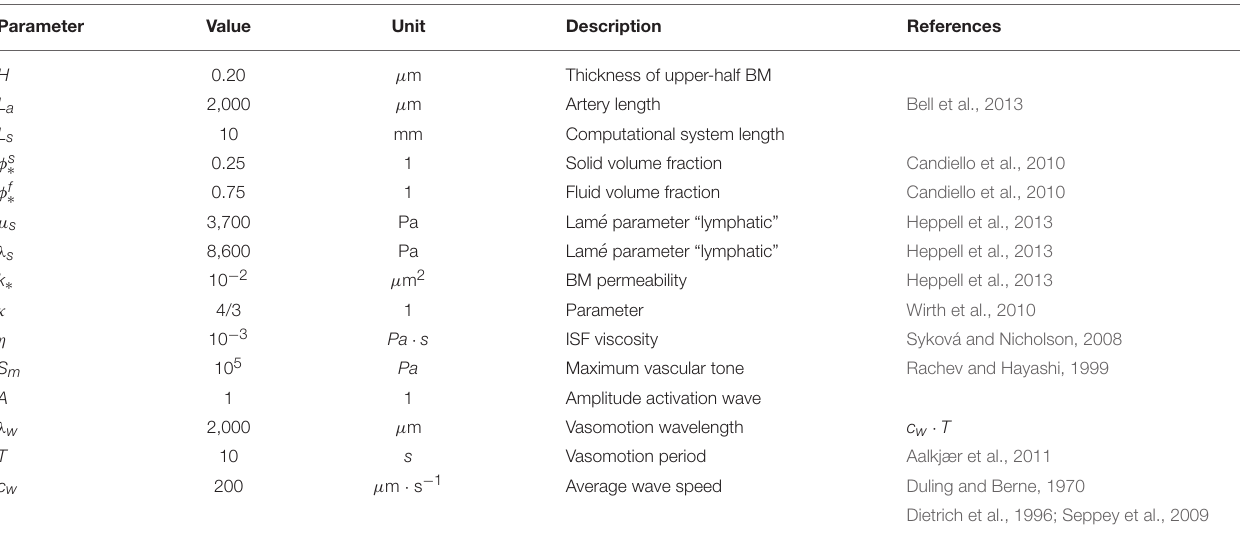
TABLE 1 | Dimensional